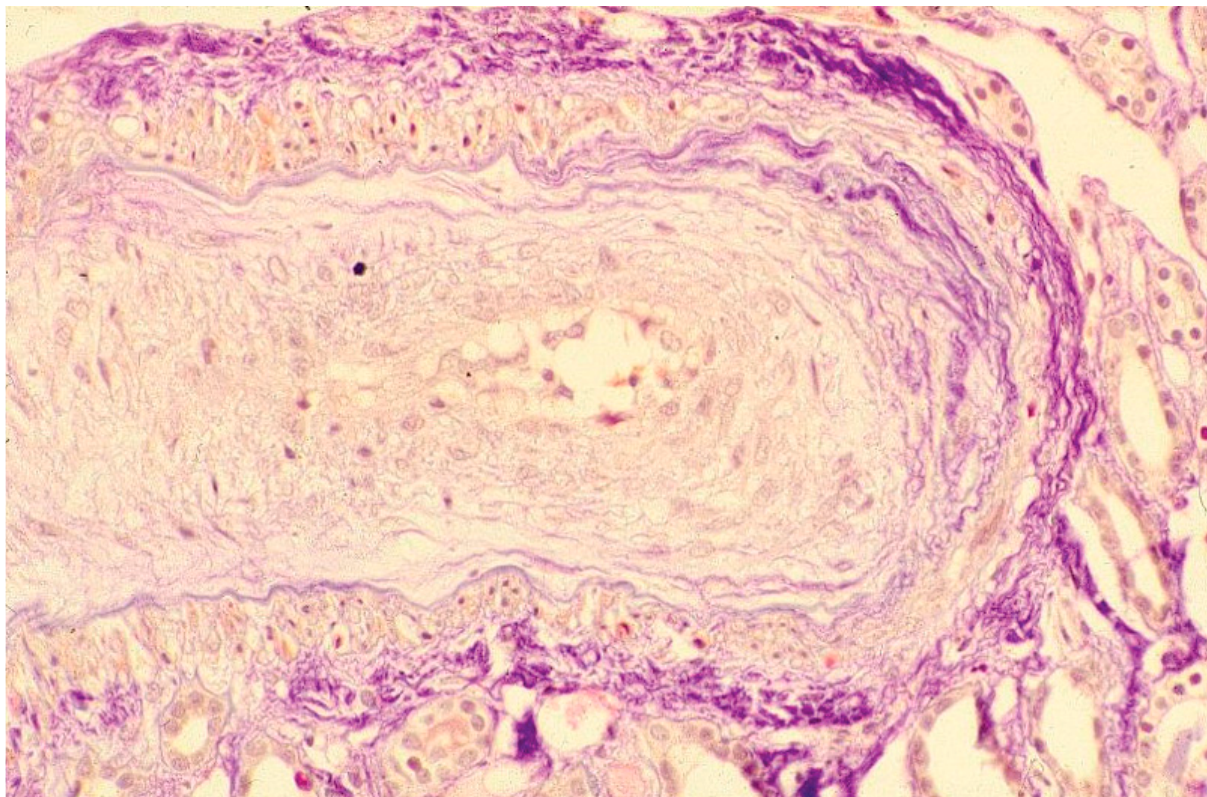
Figure 2. Light microscopy: section of an interlobular arterial wall that shows intimal mucoid edema, resulting in “onion skin” concentric appearance and a reduction in the lumen.